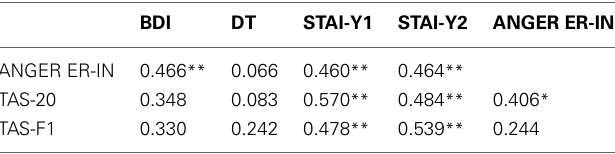
Table 5 | Correlations among Alexithymia, Anger Expression-In scores, and Psychological distress scales.